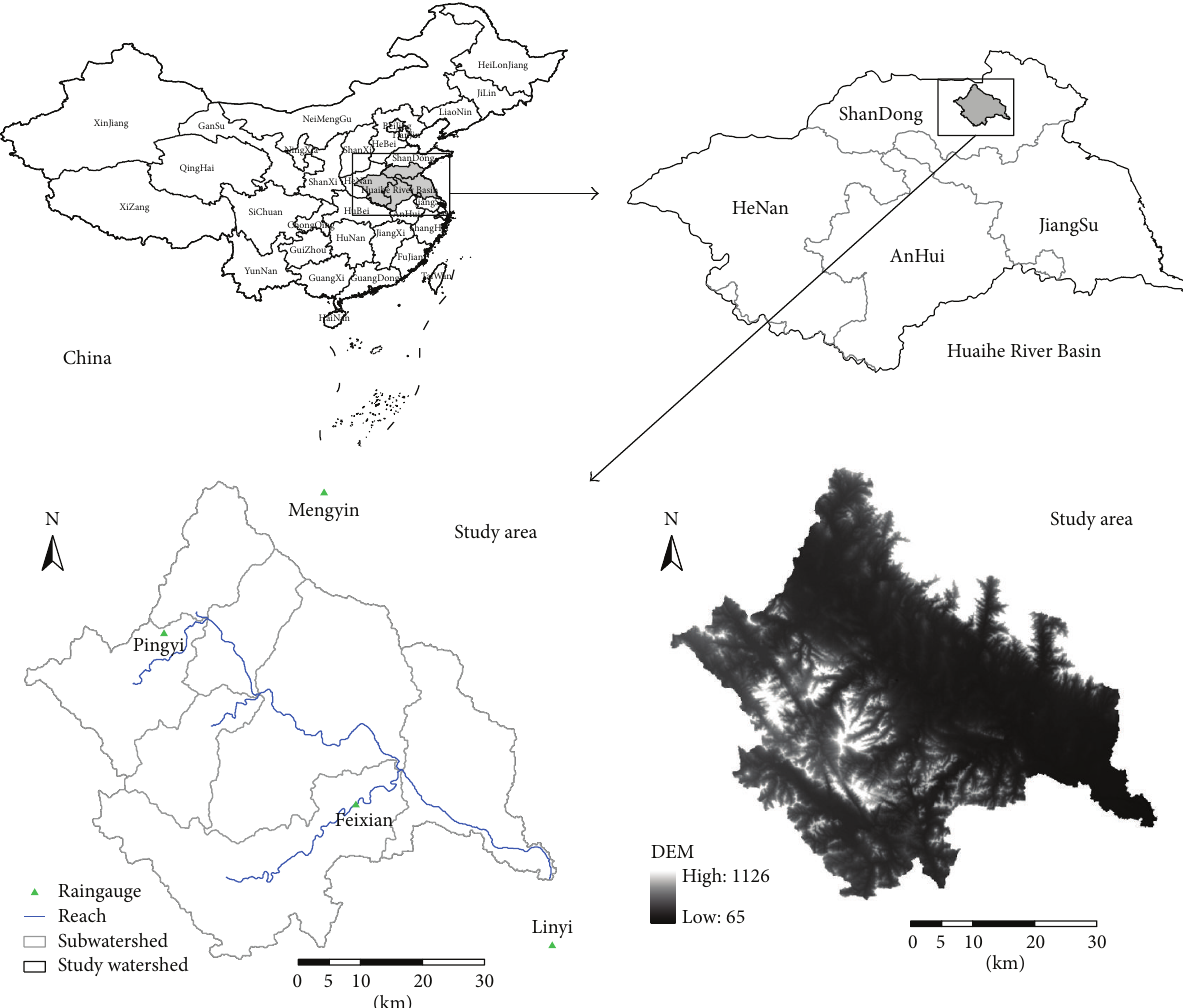
Figure 1: Geographical location of study area within Huaihe River Basin,